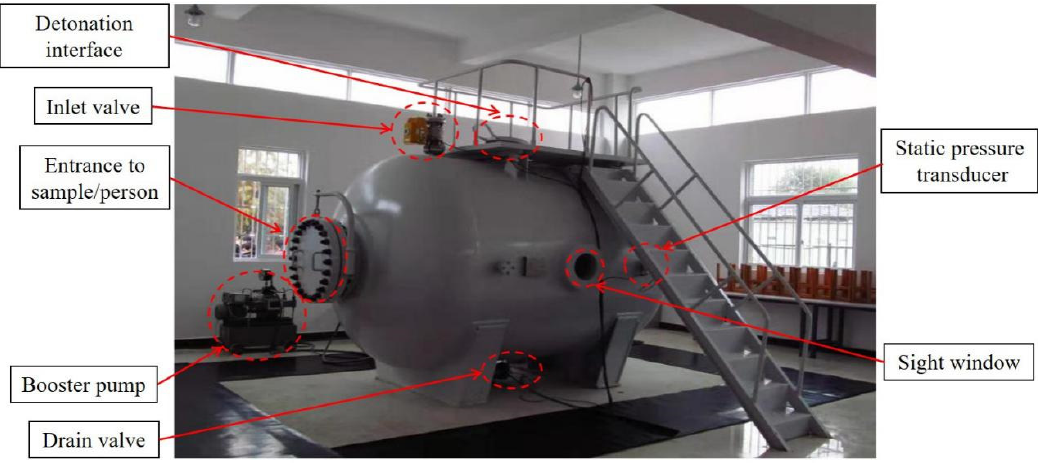
Figure 7. Water-medium explosion vessel. Table 2. Specific scheme.